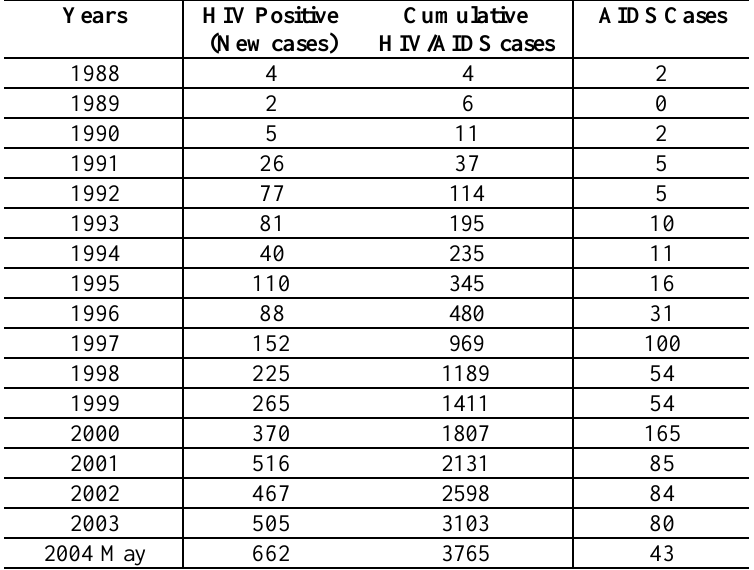
Table I : Year-wise detection of HIV/AIDS cases (National figure)